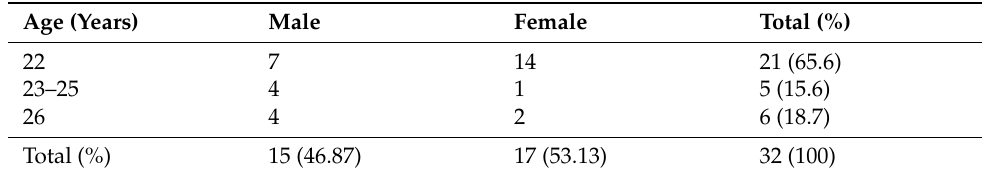
Table 1. Sex and age distribution of the